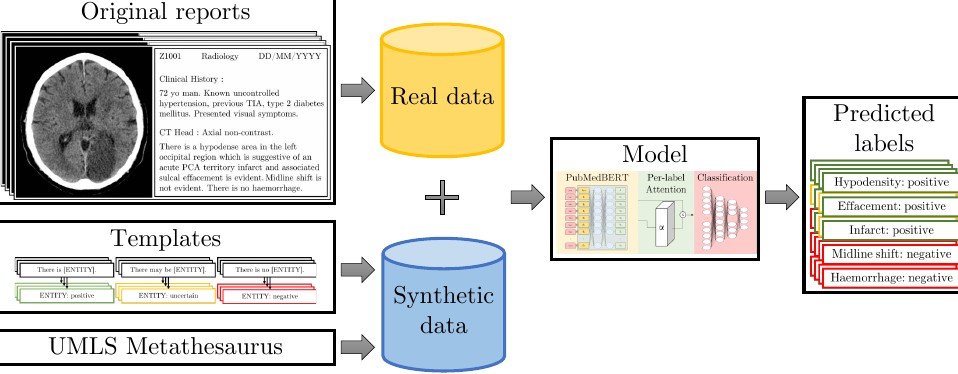
Figure 1. Our original set of radiology reports is annotated by three medical annotators (clinical researcher and medical students) at sentence-level. The training dataset is augmented with synthetic data generated from templates. We inject knowledge from the UMLS [8] meta-thesaurus and medical experts into the templates to teach the model about rare synonyms and annotation protocol rules. Our model then predicts labels for the given sentences.